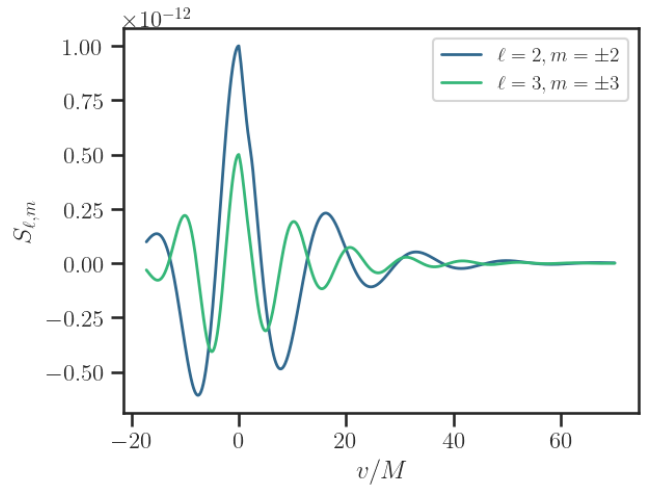
Figure 1 . Source modes with excitation coefficients s 2 , ± 2 = 2 s 3 , ± 3 = 10 − 10 . The source is asymmetric in time, since the initial growth is governed by a Gaussian pulse whereas the late time behavior by quasinormal modes.